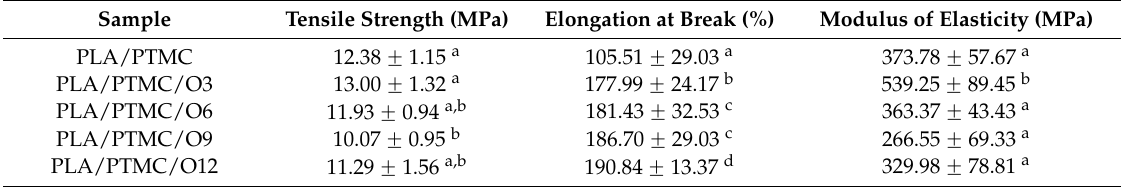
Table 3. The mechanical properties of PLA/PTMC/OEO composite